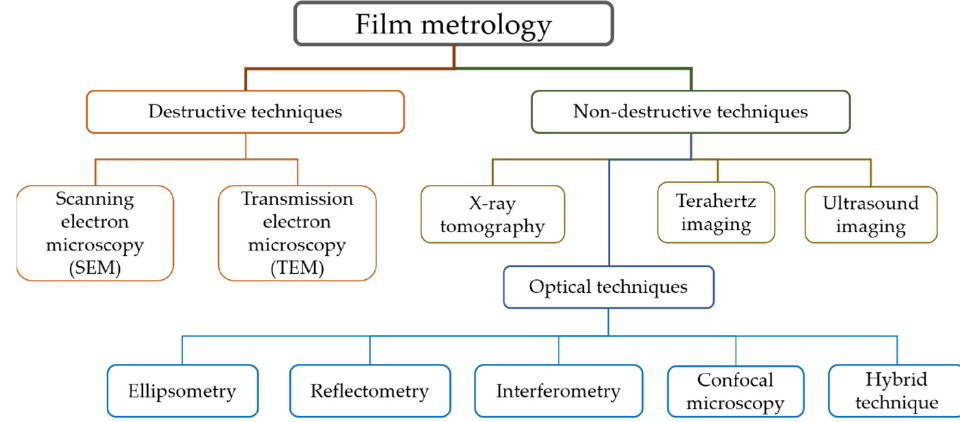
Figure 1. Schematic of technology category in film metrology as the technical point of view.